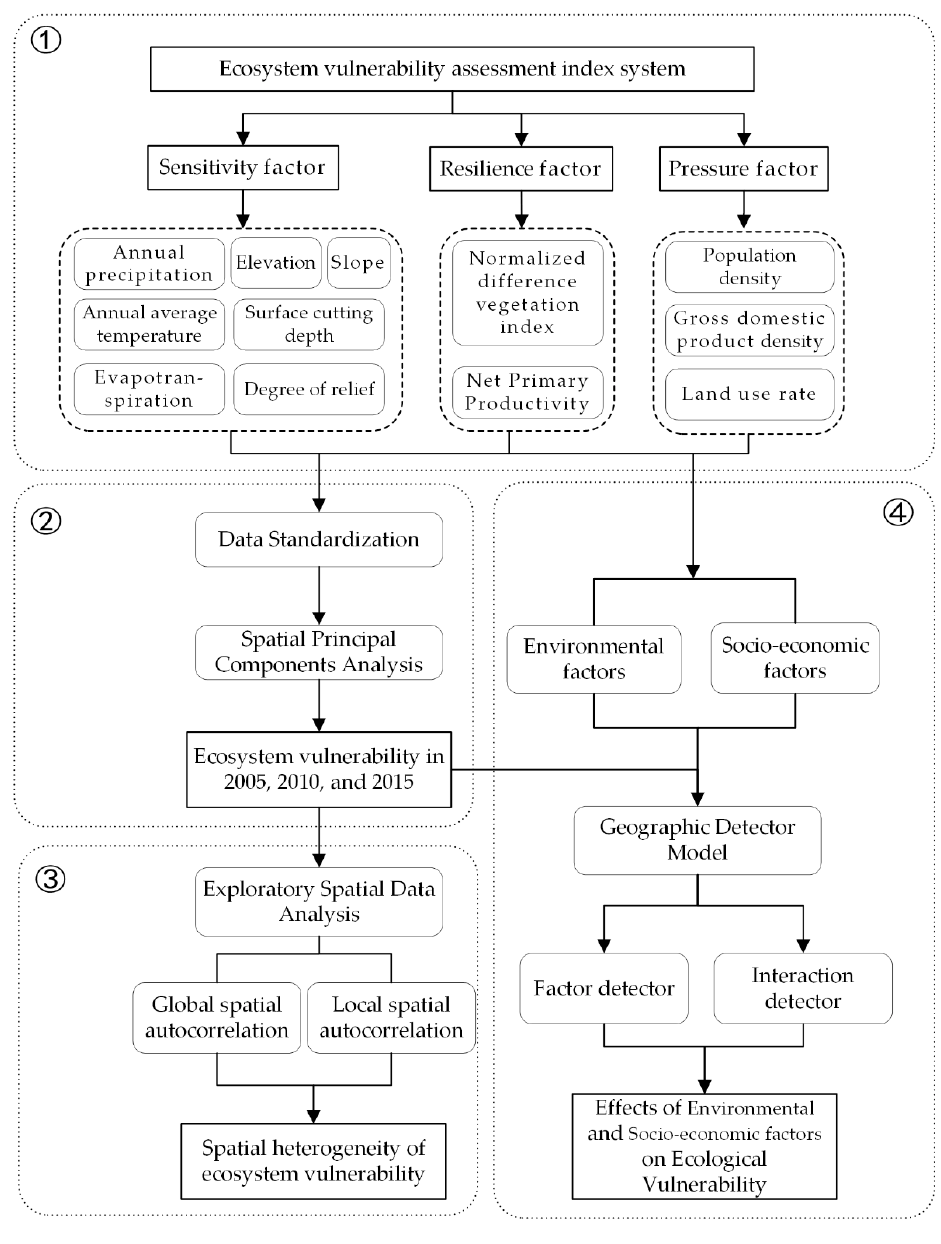
Figure 2. Flowchart showing the process followed in this analysis for assessing ecosystem vulnera- bility of the Qinghai-Tibet Plateau. bility of the Qinghai-Tibet